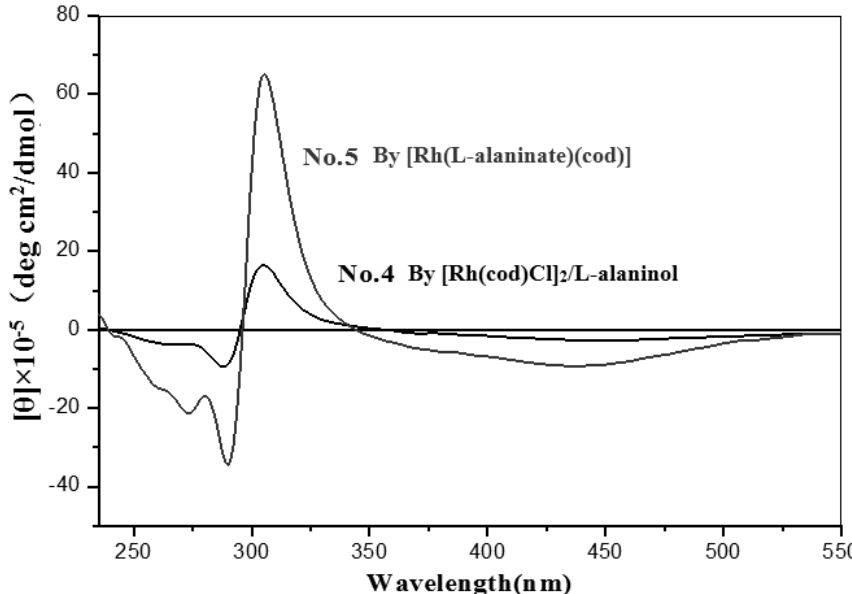
Figure 2. Circular dichroism (CD) spectra of chiral helical poly( DoDHPA ) obtained using [Rh(cod)Cl] 2 / L -alaninol and [Rh( L -alaninate)(cod)] as catalysts (CD spectra were determined in THF solution with 1.000 mmol/L poly( DoDHPA )) (Table 1, entries 4 and 5).